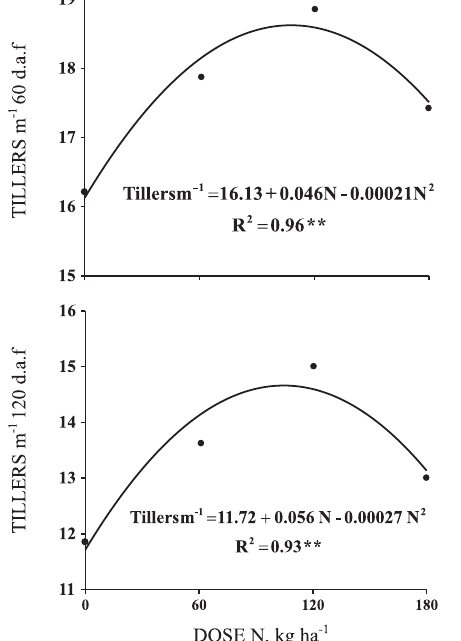
Figure 2. Number of tillers 60 and 120 days after fertilization in terms of the doses of N-NH significant at 5 %.